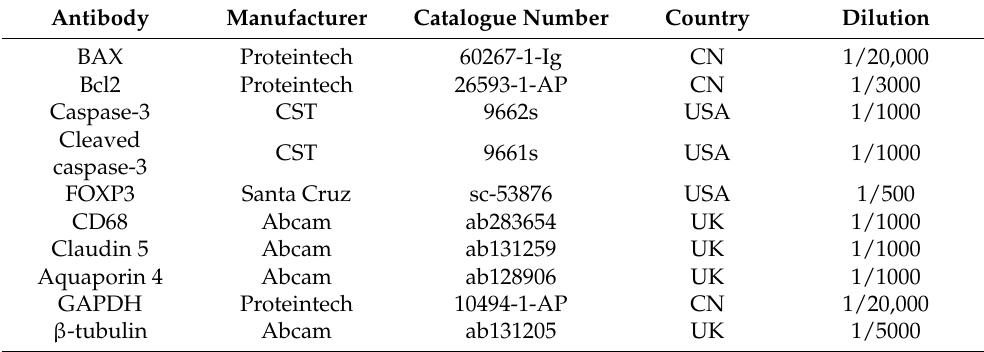
Table 2. Antibody